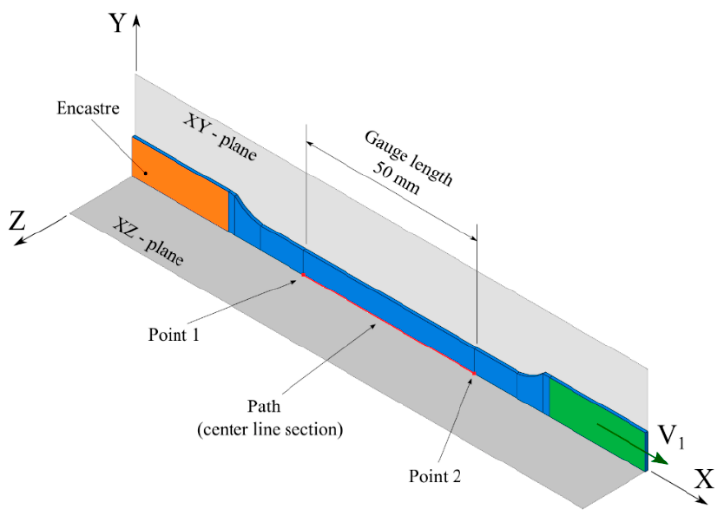
Figure 5. Boundary conditions for the uniaxial tensile specimen with 1/4 symmetry.